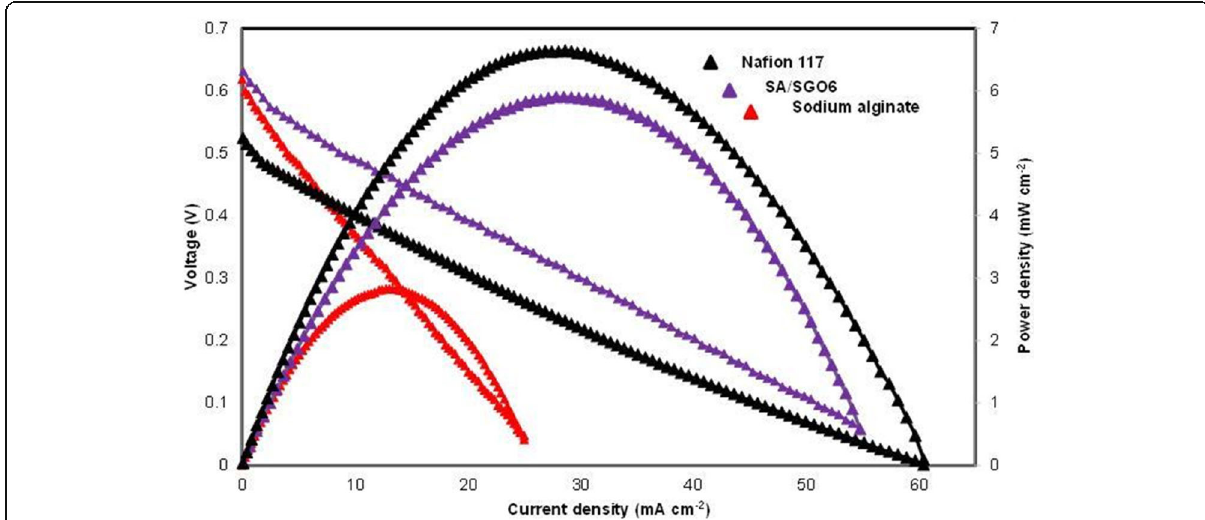
Fig. 14 Single-cell performance test for sodium alginate, SA/SGO6, and Nafion 117 (4 M methanol and 25 °C temperature, passive